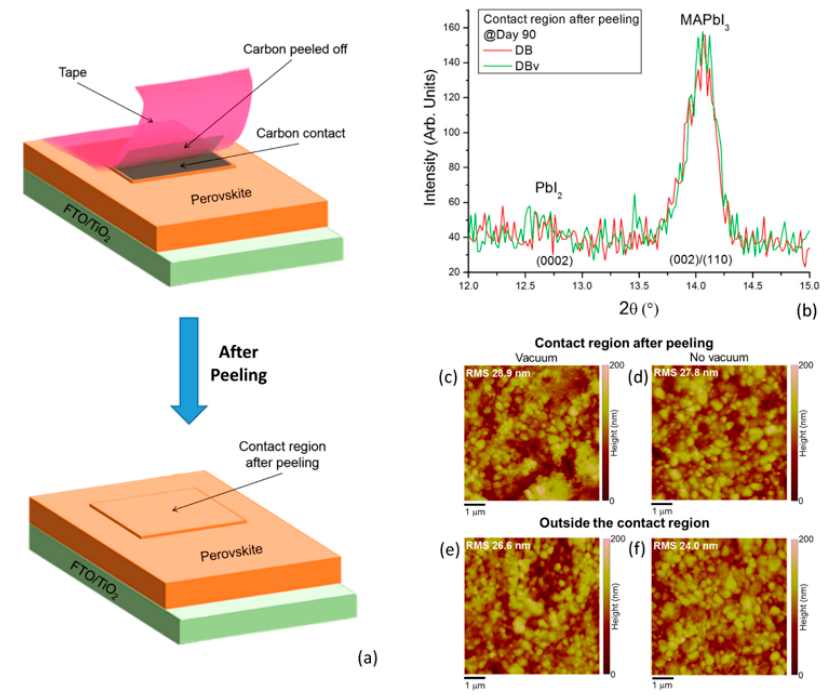
Figure 3. Bulk and surface analyses of the perovskite layer after carbon contact removal: ( a ) Schematic of the carbon contact removal by peeling; ( b ) XRD patterns of representative DB-PSC and DBv-PSC acquired at day 90 inside the contact region after peelings. The diffraction patterns are labeled with the related Miller indexes of the hexagonal (PbI 2 ) and tetragonal (MAPbI 3 ) phases. Atomic force microscopy (AFM) morphologies inside ( c ),( d ) and outside ( e ),( f ) the contact region after peeling in DB-PSC and DBv-PSC. Energies 2020 , 13 , x FOR PEER REVIEW